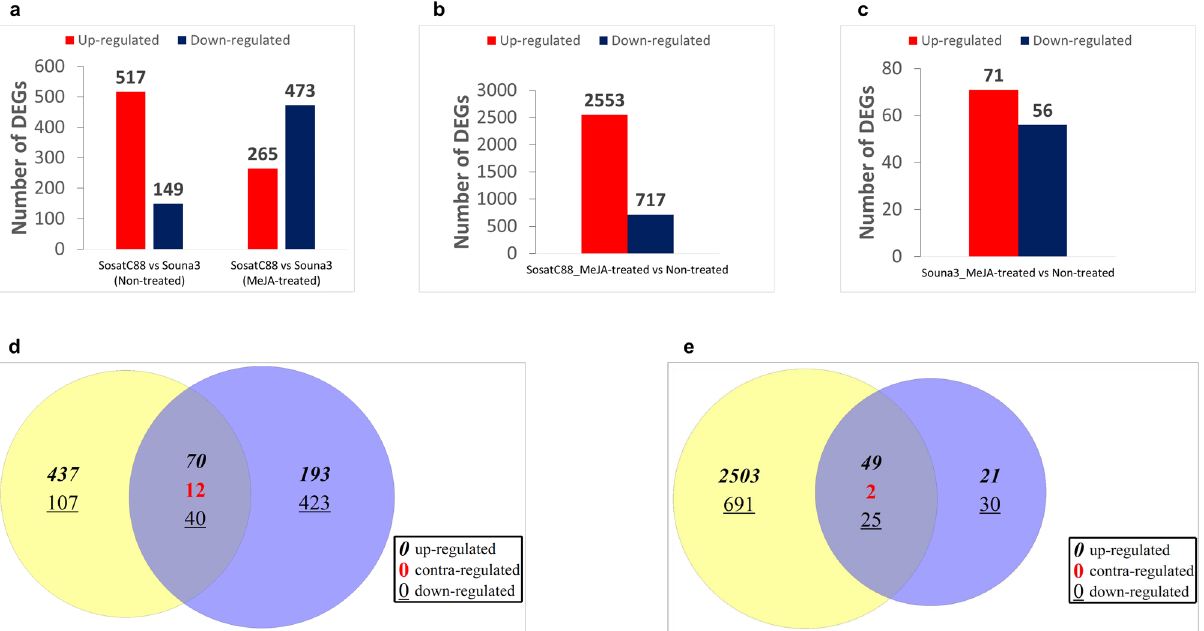
Figure 2. ( a , b and c ) Number of DEGs in all combinations with fold change > 2 or < -2 and FDR-corrected p -value < 0.05) Red and blue bars indicate up-regulated and down-regulated respectively; ( d ) Venn diagram of number of differentially expressed transcripts in ‟ SosatC88 vs Souna3 (non-treated)” (yellow) and ‟ SosatC88 vs Souna3 (MeJA-treated)” ( blue); ( e ) Venn diagram of number of differentially expressed transcripts in ‟ SosatC88_MeJA- treated vs non-treated” ( yellow) and ‟ Souna3_MeJA- treated vs non-treated”